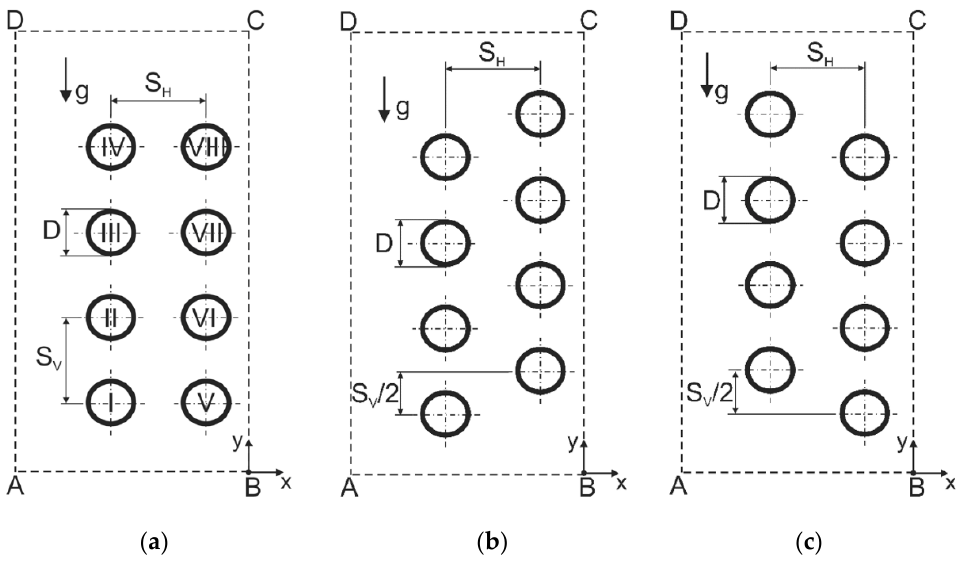
Figure 1. Arrangement of the single cylinder and tube arrays 4 × 1 and 4 × 2: ( a ) single cylinder; ( b ) 4 × 1 tube array; ( c ) 4 × 2 tube array.